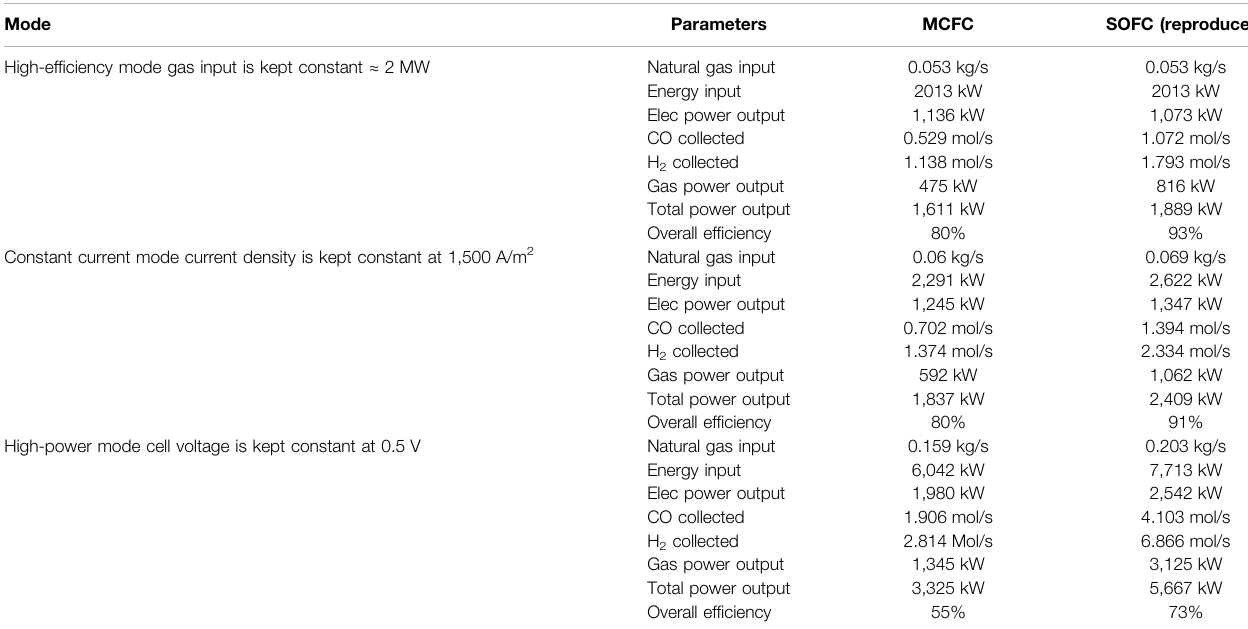
TABLE 2 | Comparison of results between the two fuel cells at fuel utilization (u f ) of 60% where the overall ef fi ciency is much higher than conventional fuel cell operation. The results for SOFC have been reproduced based on information provided in Hemmes et al. (2008).